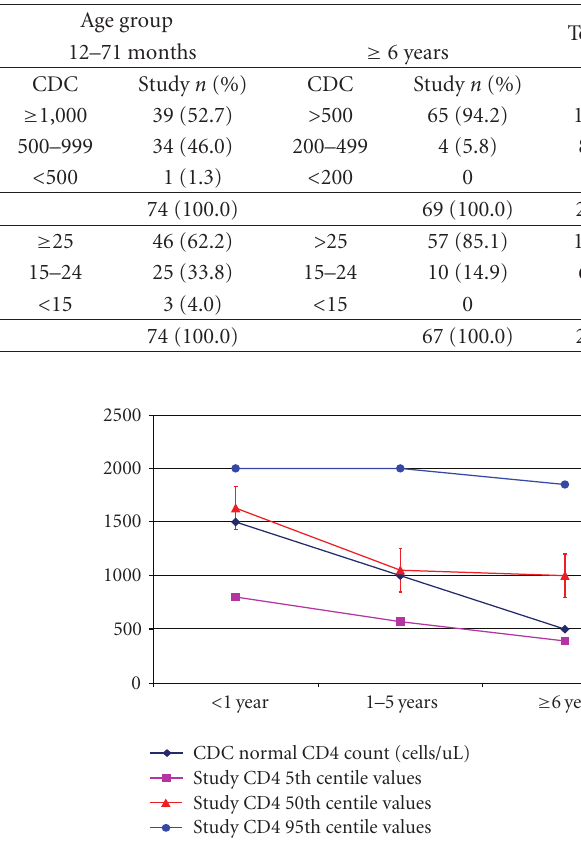
Figure 1: Comparison of median CD4 percent with the WHO nor- mal values.